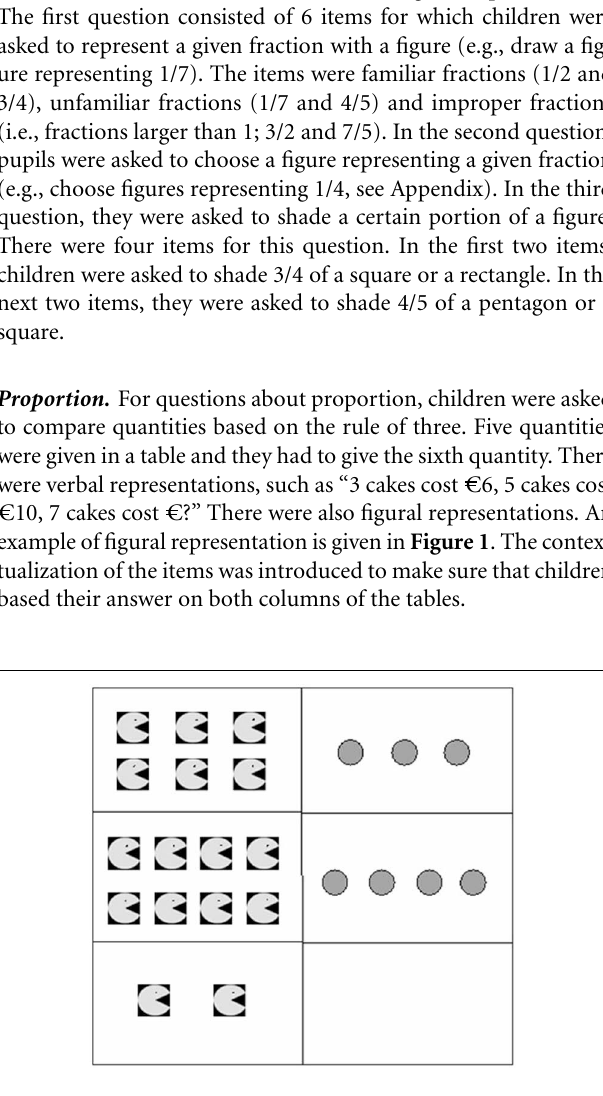
FIGURE 1 | Example of a figural proportion